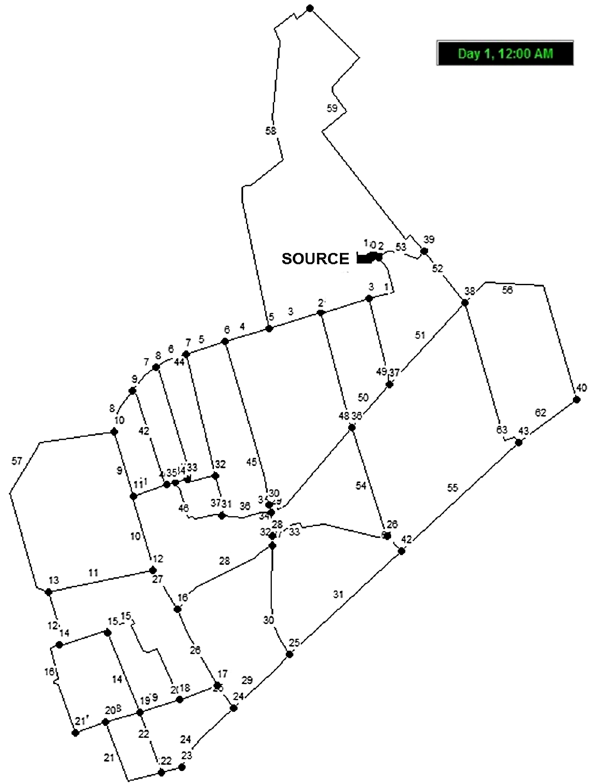
Fig. 3 Diagram of the water supply network reflecting the existing state